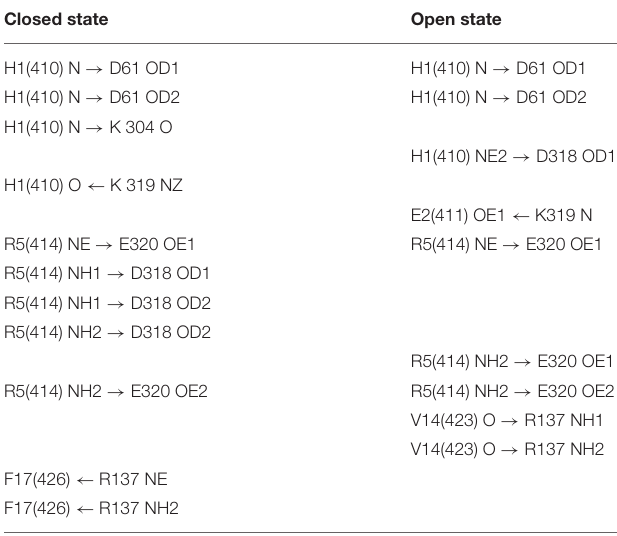
TABLE 4 | Hydrogen bonding between DP cpvtN2 and domains A, B of NTR. Closed